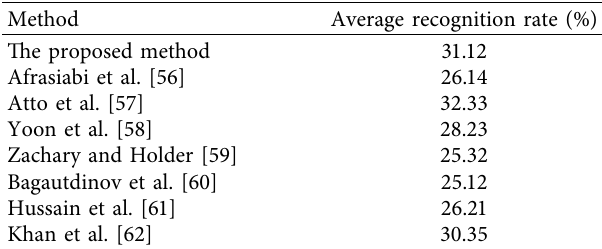
Table 6: Compared with other approaches on the Vlog dataset dataset (strong occlusion and high dynamic video).